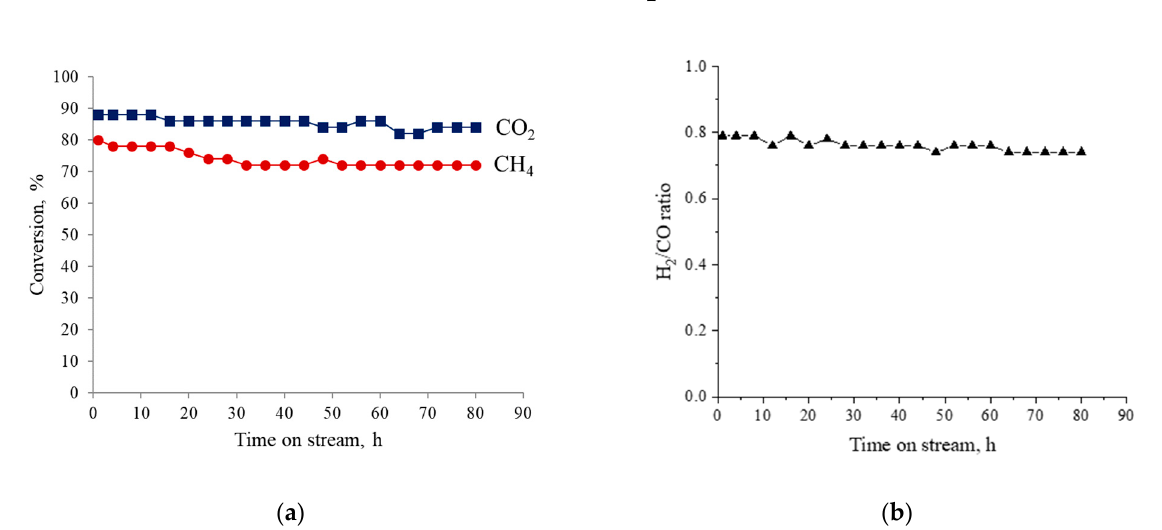
Figure 4. ( a ) CH 4 and CO 2 conversion; ( b ) H 2 /CO ratio as a function of time on stream over